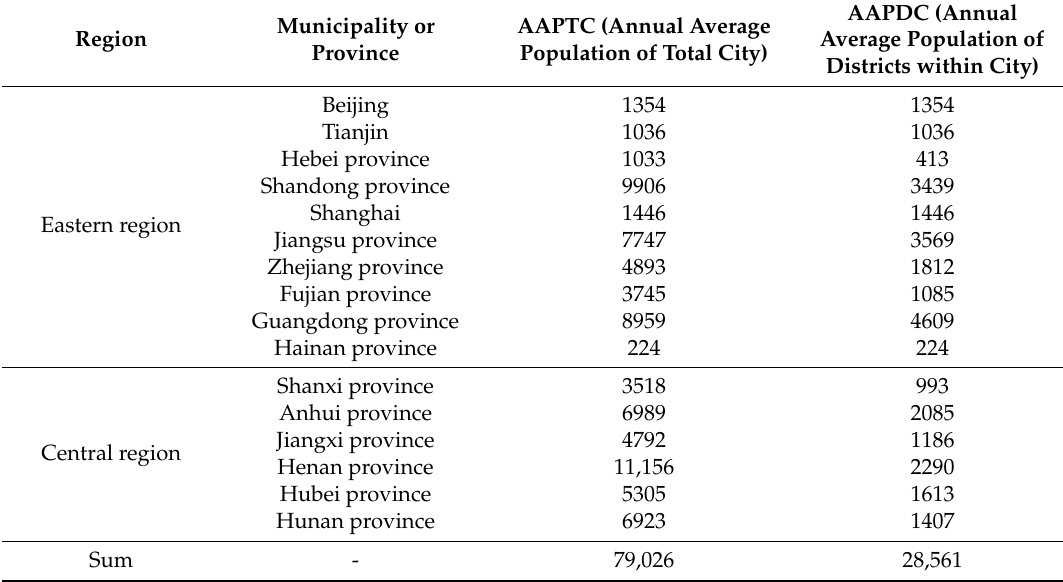
Figure 4. Scatter diagrams for linear regression results of population and TNL: ( a ) TNL of LJ1-01 data and AAPTC; ( b ) TNL of NPP/VIIRS data and AAPTC; ( c ) TNL of LJ1-01 data and AAPDC; ( d ) TNL of NPP/VIIRS data and AAPDC. Table 5. Average annual population statistics of the study area (unit: 10,000 people).